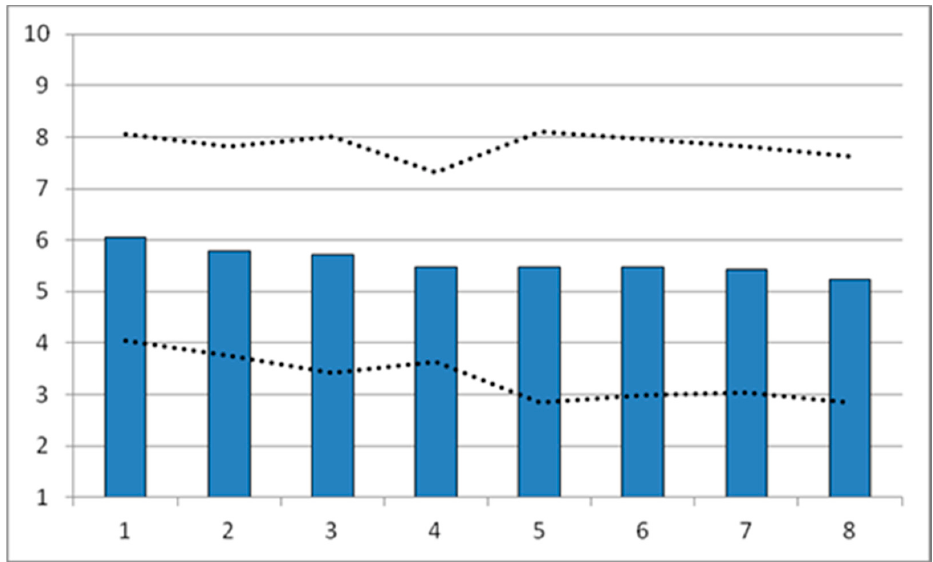
Figure 3. Graphic image of arithmetic means X ± S of individual factors, based on the opinions of service providers. Figure Legend: 1. Preparation of infrastructure for residents; 2. Expansion of infrastructure; 3. Promoting the idea of an active lifestyle; 4. Promoting sports for children and teenagers; 5. Poznan as an international sports center; 6. Supporting mass sport; 7. Creating the city’s image through sports and recreation; 8. Operation of sports